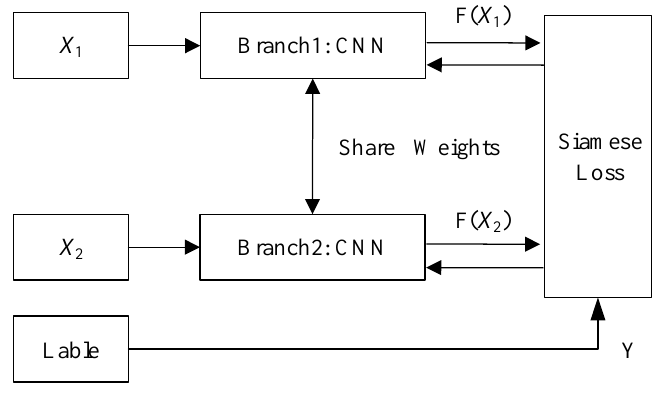
Figure 1. The structure of the Siamese network.